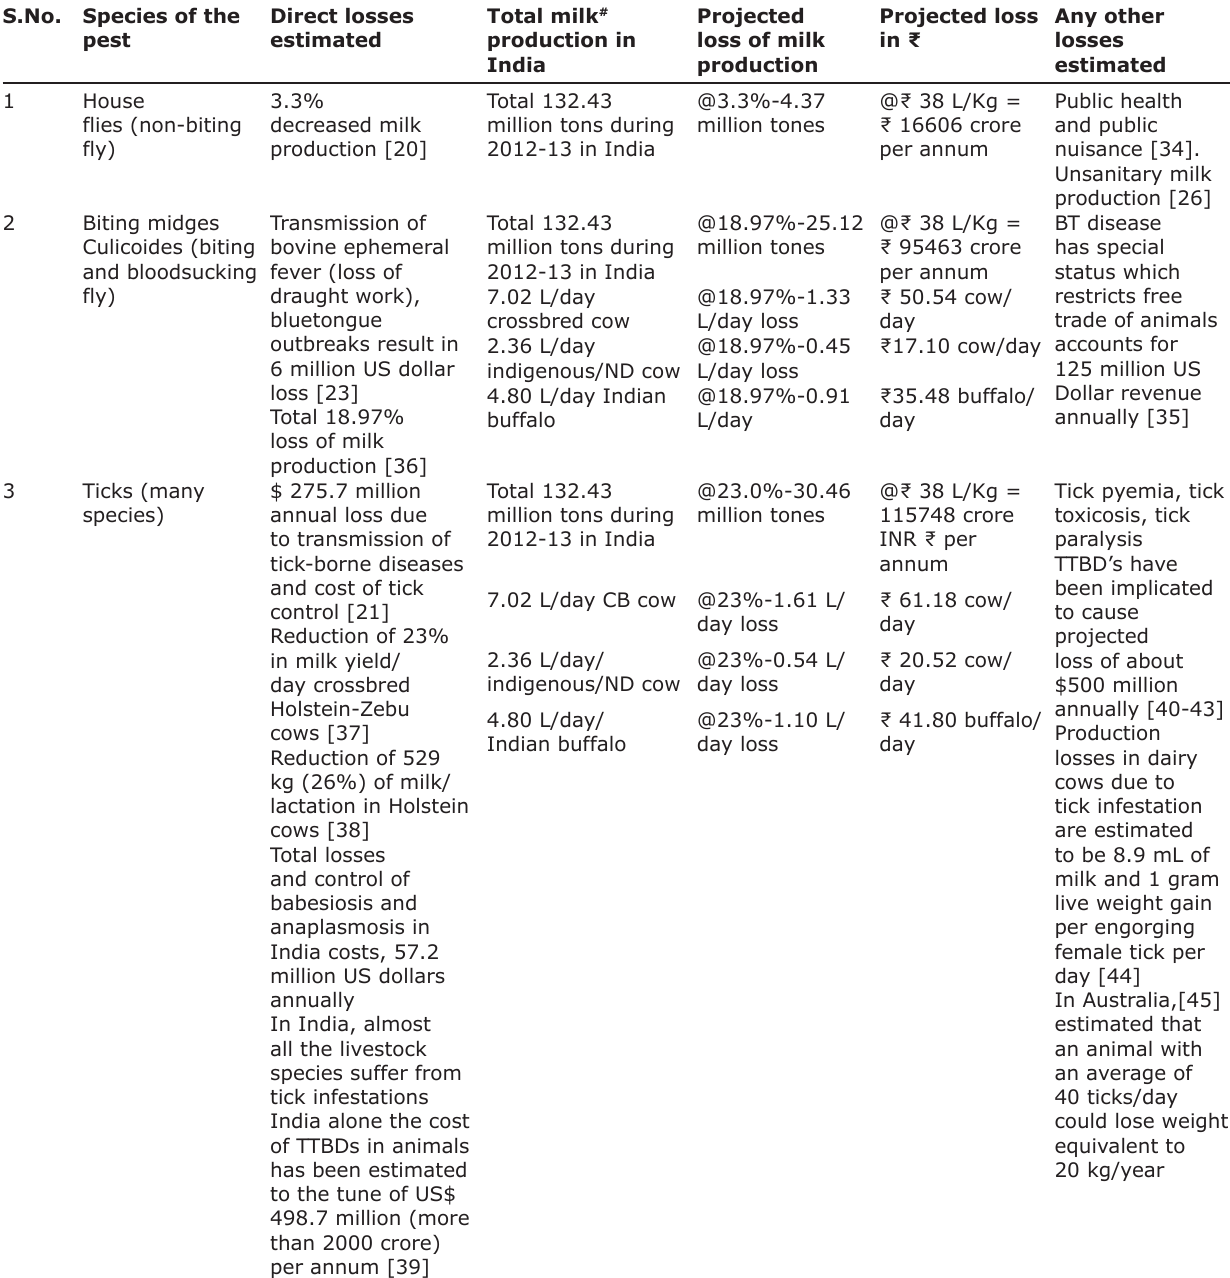
Table-2: Projected economic losses from important vectors-cum-pests of livestock in